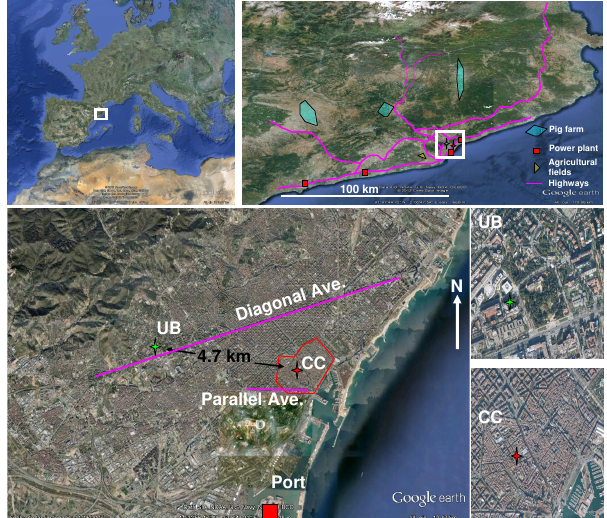
Fig. 1. Location of the two measurement sites in Barcelona (NE Spain): UB (traffic-influenced urban background) and CC (histori- cal city center). Type and location of potential sources of NH 3 are reported in the